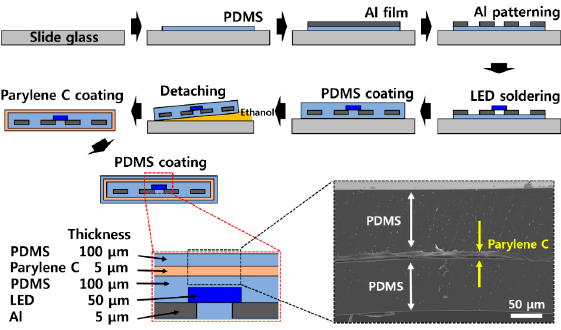
Figure 1 . Schematic illustration of the fabrication process and side view of layers. Figure 1. Schematic illustration of the fabrication process and side view of layers.